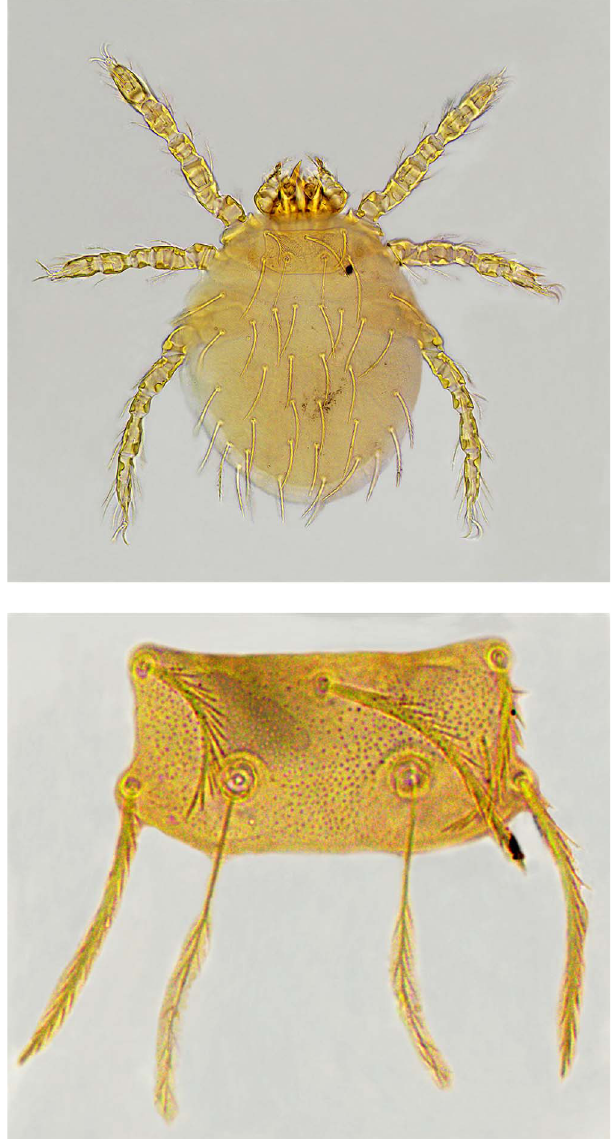
Figure 3. Photos of Leptotrombidium densipunctatum (10 (cid:1) 40), the most dominant chigger species on Anourosorex squamipes in Southwest China (top: the whole chigger; bottom: the